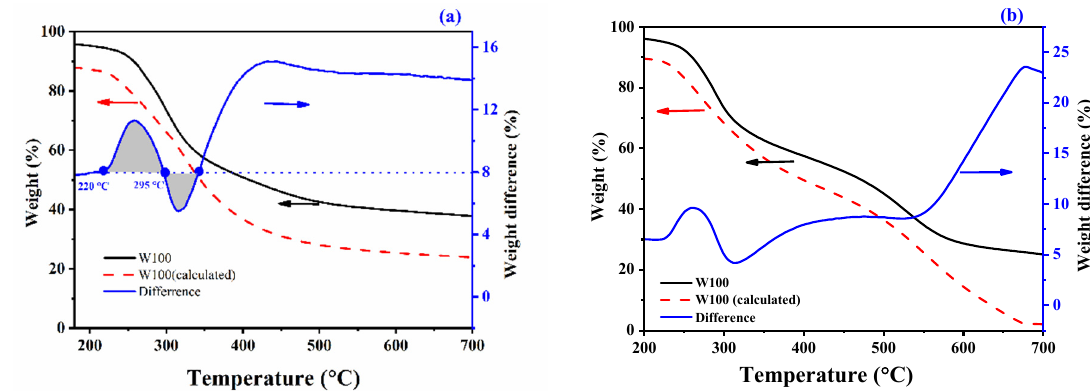
Figure 6. Difference between the actual and calculated TG curves of the PBTCA-treated wool in nitrogen ( a ) and air ( b ).